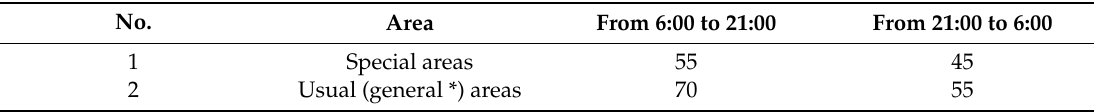
Table 2. Vietnamese National Technical Regulation on Noise ( QCVN 26:2010 / BTNMT )—permissible noise limits (in decibel), L A (dB).